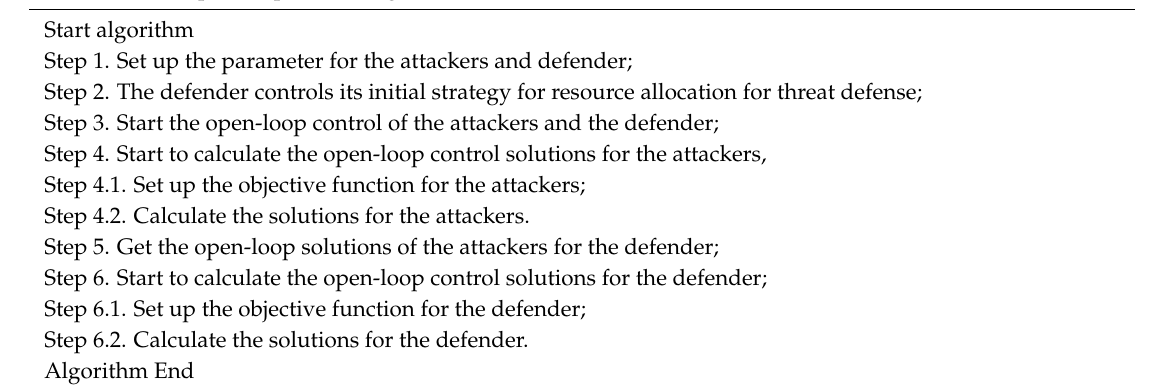
Algorithm 1. Open-loop control algorithm for the attackers and